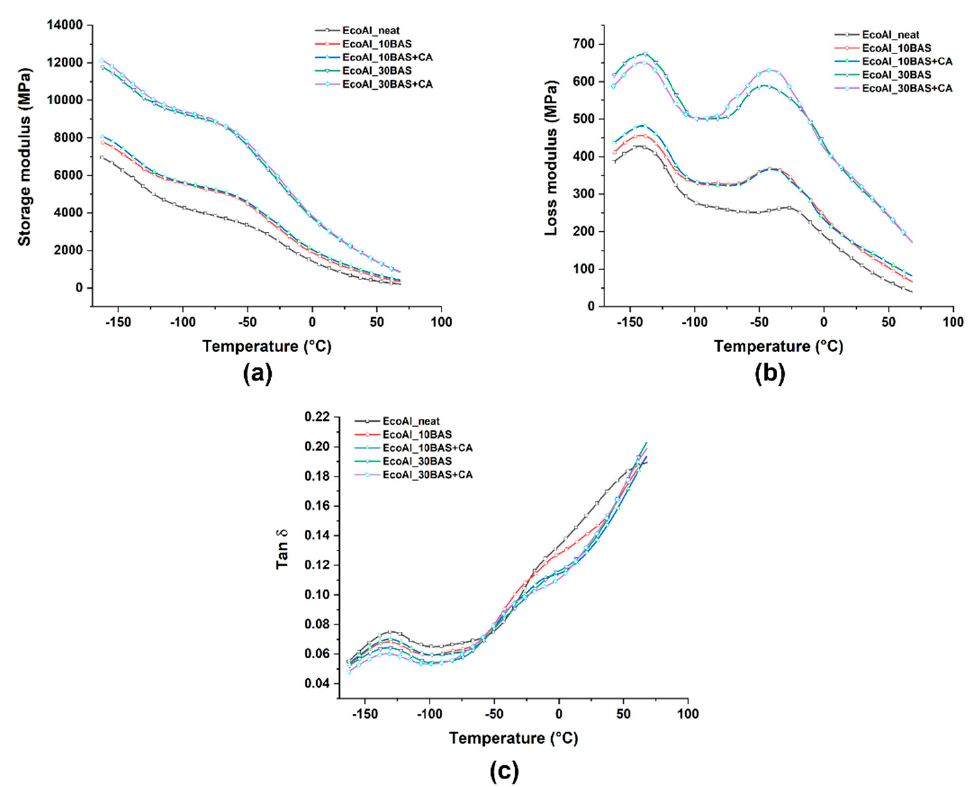
Figure 8. ( a ) Storage modulus, ( b ) loss modulus and ( c ) tan δ curves as a function of temperature for all EcoAllene-based composites.